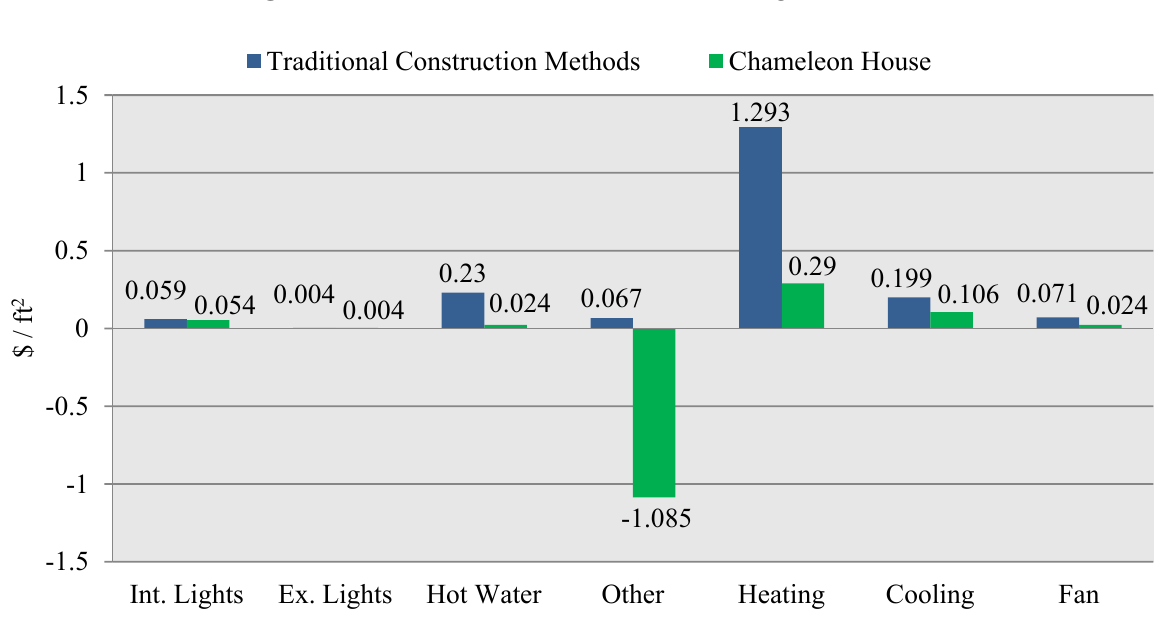
Figure 9. Annual cost breakdown—Including PV